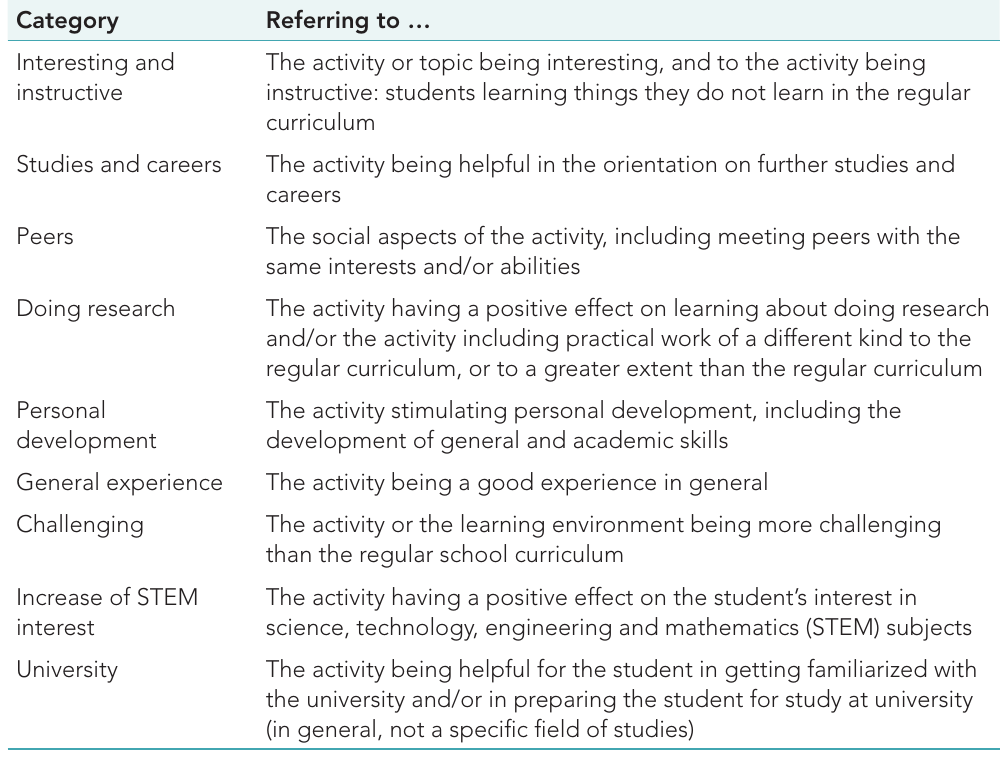
Table 3: Categories of motivation and experience statements by students